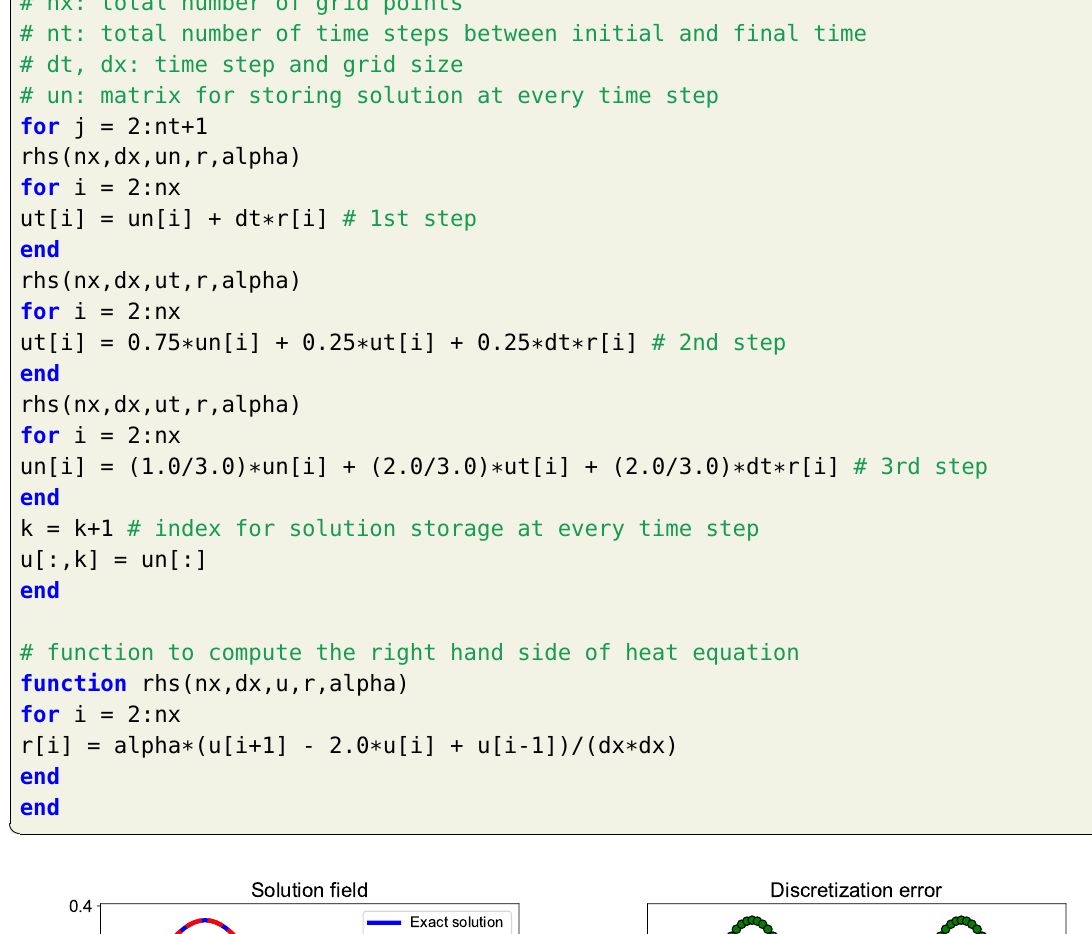
Listing 2. Implementation of third-order Runge-Kutta numerical scheme for heat equation in Julia. (cid:7)